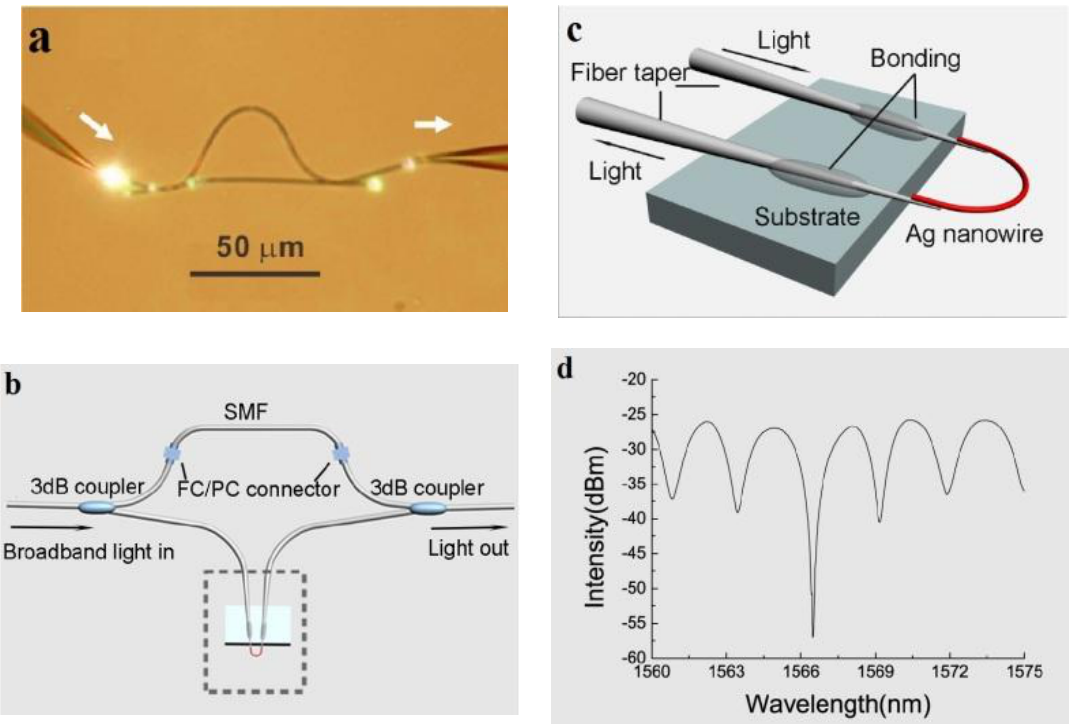
Figure 14. Microfiber-based MZI. ( a ) Optical microscope image of a MZI assembled with two 480 nm diameter tellurite microfibers. White light from a supercontinuum source is launched into and picked up from the MZI by two silica fiber tapers. The white arrows indicate the direction of light propagation [79]; ( b ) Schematic of a hybrid photonic-plasmonic MZI. The structure in the dashed box represents the in-fiber return-signal plasmonic probe; ( c ) A closed-up view of the plasmonic probe; ( d ) Typical transmission spectrum of the hybrid MZI